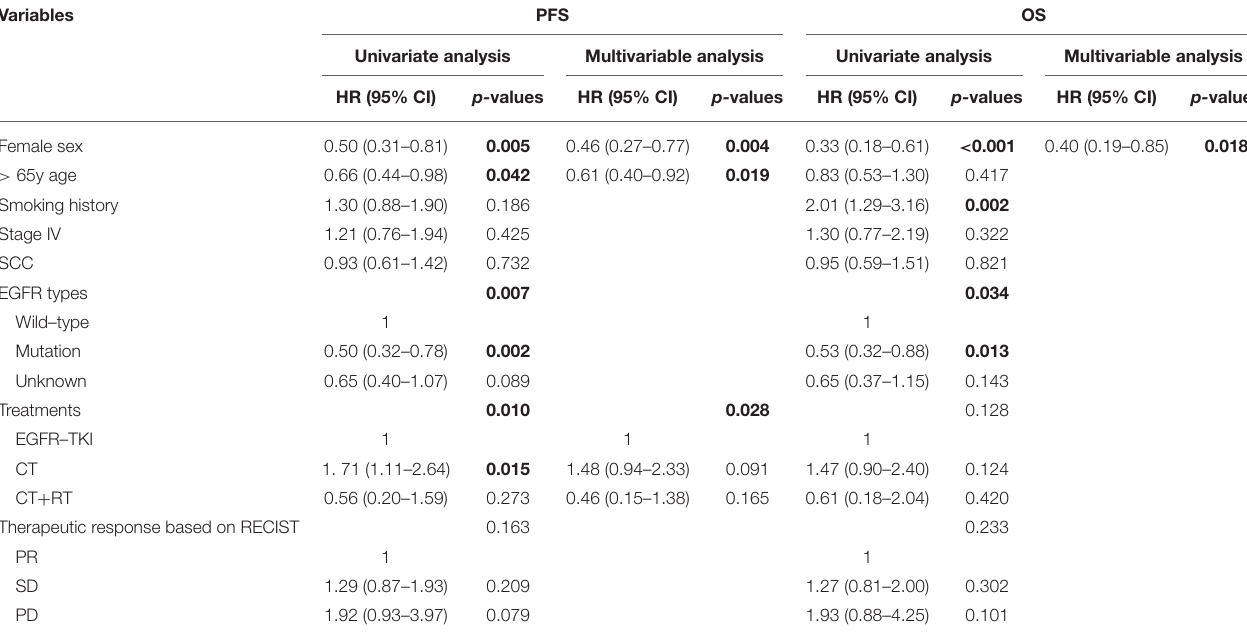
TABLE 5 | Cox regression based on RECIST in total